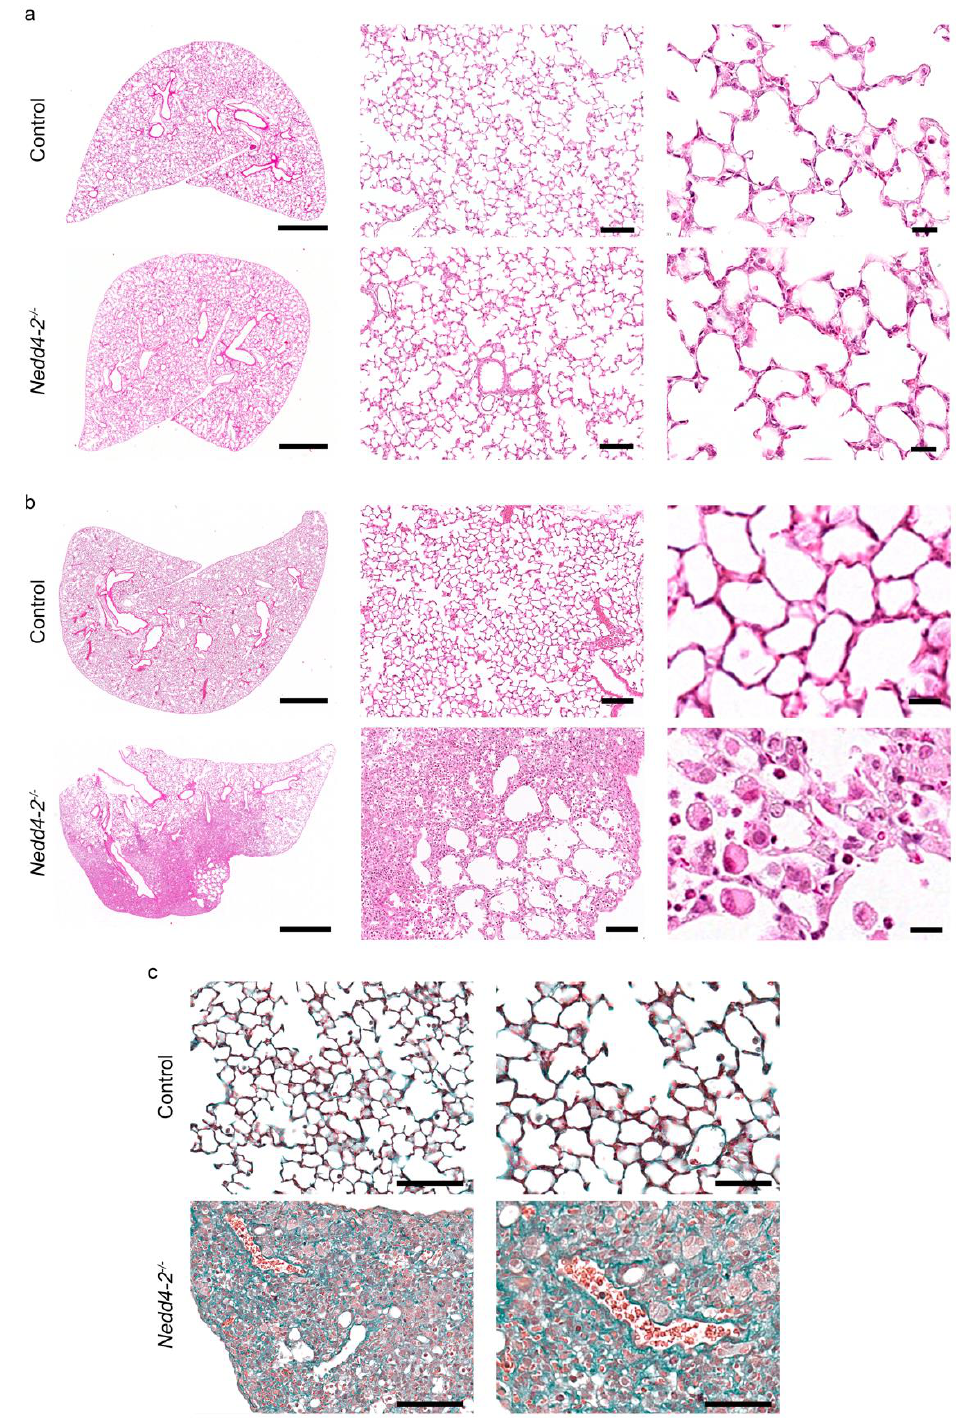
Figure 2. Congenital deletion of Nedd4-2 in lung epithelial cells causes alveolar inflammation and fibrosis in neonatal mice: ( a , b ) Representative micrographs of H&E stained lung sections of 10-day-old ( a ) and 3-week-old ( b ) congenital Nedd4-2 − / − and control mice. Scale bars, 1 mm (left column), 100 µ m (middle column) and 15 µ m (right column). ( c ) Masson-Goldner-Trichrome stained lung sections of 3-week-old congenital Nedd4-2 − / − and control mice. Scale bars, 100 µ m (left column) and 50 µm (right column). n = 7–10 mice per group.